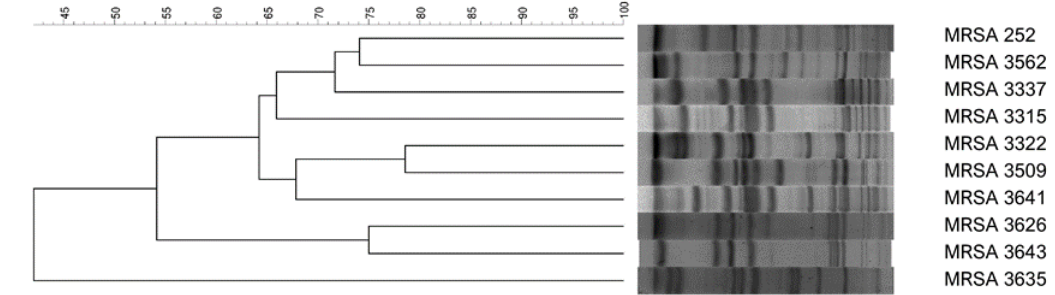
Figure 1. Pulsed-field gel electrophoresis patterns of all methicillin-resistant Staphylococcus aureus (MRSA) isolates.